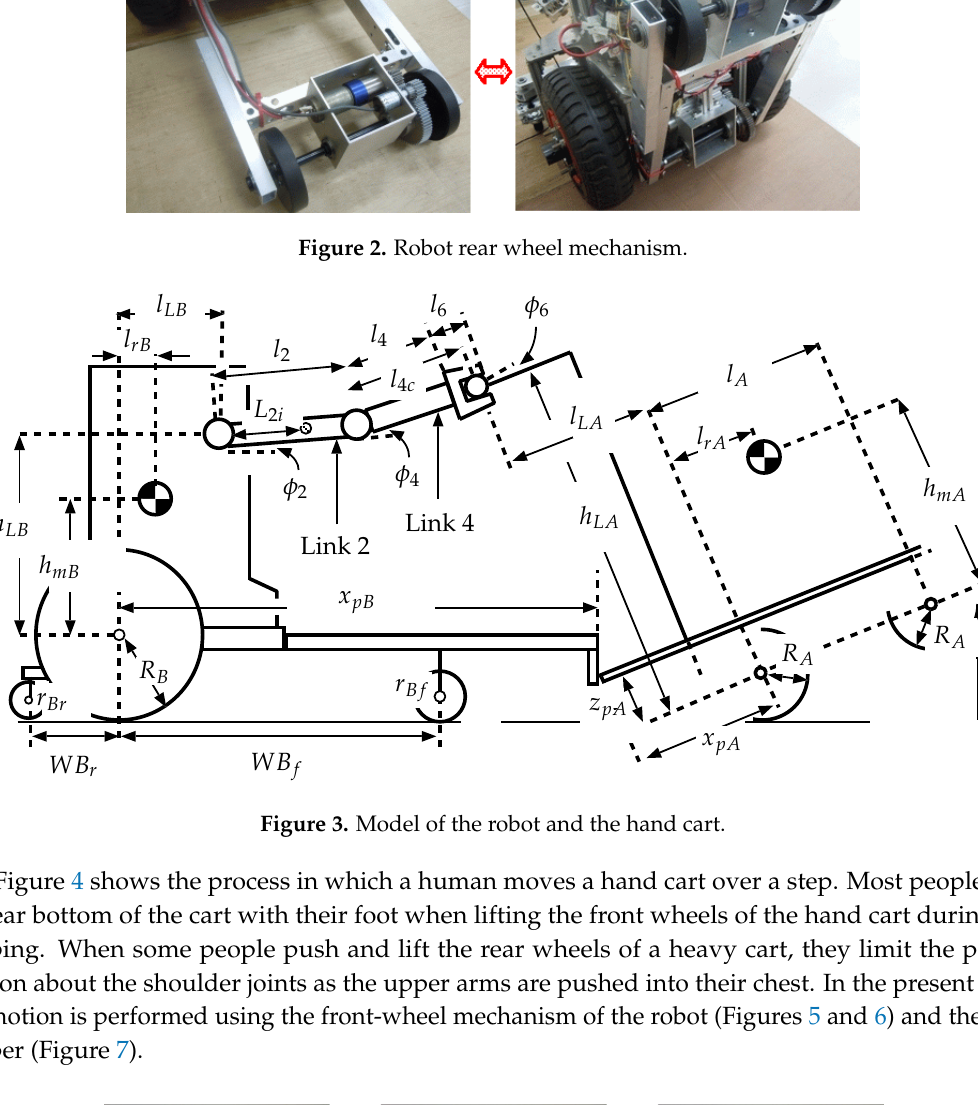
Figure 5. Extendable robot front-wheel mechanism As described below (Section 3), the manipulators are pulled when lifting the front wheels of the cart 83 so that the front-wheel mechanism of the robot can reach the rear bottom of the cart when lifting the 84 front wheels of the cart. 85 Figure 6. Robot pushing against the bottom of a hand cart using the front-wheel mechanism